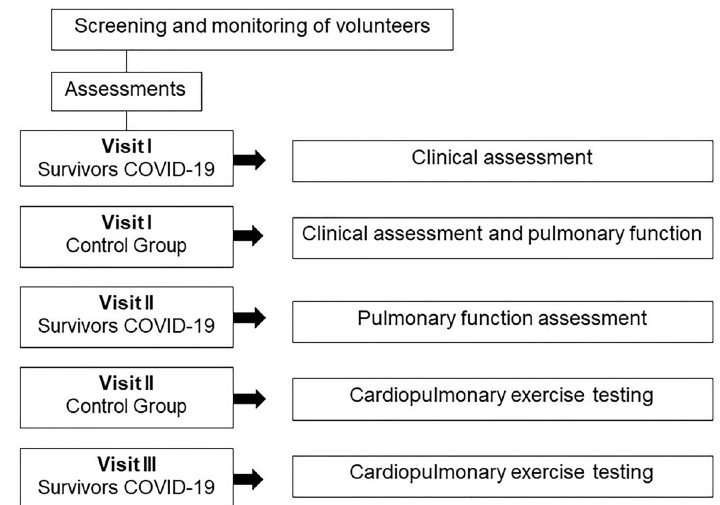
Figure 1. Evaluation fl ow